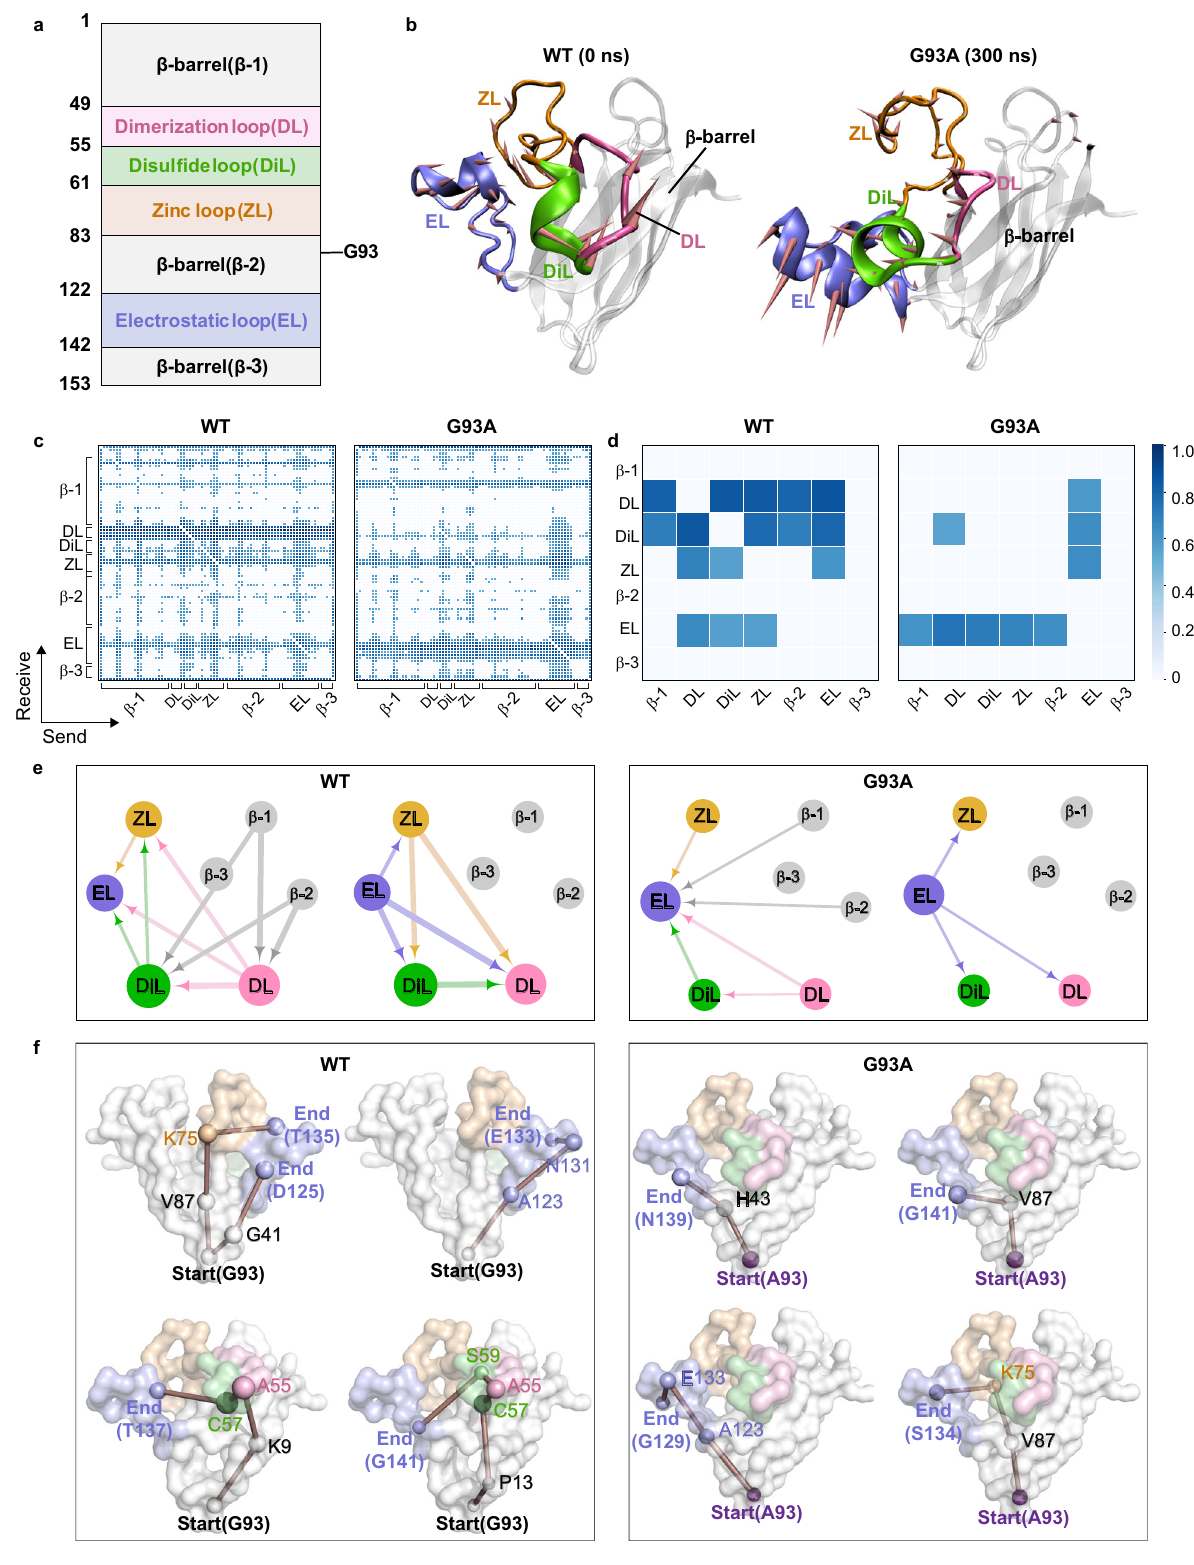
(Supplementary Fig. 11) re fl ects the activation segment ’ s open trend in the active